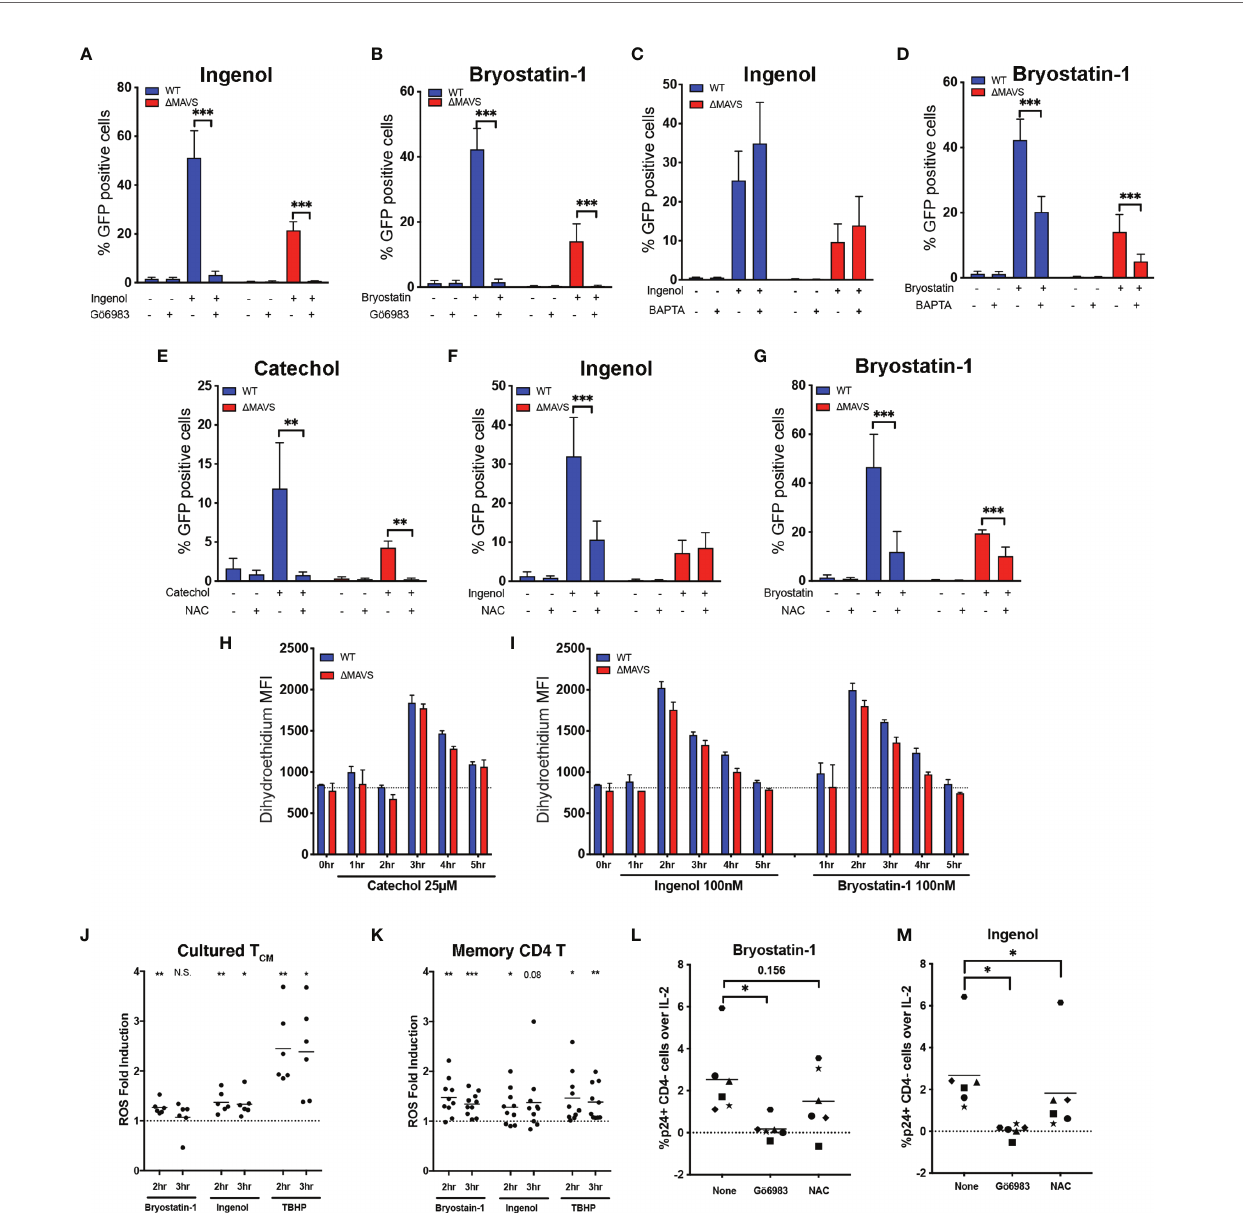
FIGURE 6 | ROS plays a role in viral reactivation mediated by Cathecol and PKC agonists. J-Lat-WT and J-Lat- D MAVS clones were tested in their ability to reactivate latent HIV-1 with Ingenol or Bryostatin- in the presence of the PKC inhibitor Gö6983 (A, B) or the calcium chelator BAPTA (C, D) . J-Lat-WT and J-Lat- D MAVS clones were tested in their ability to reactivate latent HIV-1 with Catechol (E) , Ingenol (F) or Bryostatin-1 (G) in the presence of an antioxidant, NAC. % GFP positive cells were measured by fl ow cytometry. Data are represented as mean ± SD of three to fi ve biological replicates performed in triplicates. Mann-Whitney test was used to calculate p-values between the agonists in the presence or absence of inhibitor. J-Lat-WT and J-Lat- D MAVS clones were treated with Catechol (H) , Ingenol or Bryostatin-1 (I) and superoxide generation was assessed by fl ow cytometry up to 5 hours post-treatment. Data are represented as mean ± SD of one of three biological replicate perform in triplicates. (J) Primary cultured T CM cells generated from 6 donors were treated with Bryostatin-1, Ingenol, or TBHP for the times indicated. Cells were stained using dihydroethidium and analyzed by fl ow cytometry. Horizontal line indicates mean. One column t-test relative to untreated control was used to calculate p-values. (K) Total memory CD4+ T cells were isolated from PBMCs from 10 healthy donors. Cells were treated with Bryostatin-1, Ingenol, or TBHP for the times indicated. Cells were stained using dihydroethidium and analyzed by fl ow cytometry. Horizontal line indicates mean. One column t-test relative to untreated control was used to calculate p-values. Latently infected cultured T CM cells from 6 donors were preincubated for 1 hour with either Gö6983 or NAC and then treated with Bryostatin-1 (L) or Ingenol (M) . %p24 positive CD4 negative cells over IL-2 control were measured 48 hours post treatment by fl ow cytometry. Horizontal line indicates mean. Wilcoxon matched-pairs signed rank test relative to no inhibitor (None) control was used to calculate p-values. (*p < 0.05; **p < 0.01; ***p < 0.001). ns, not signi fi